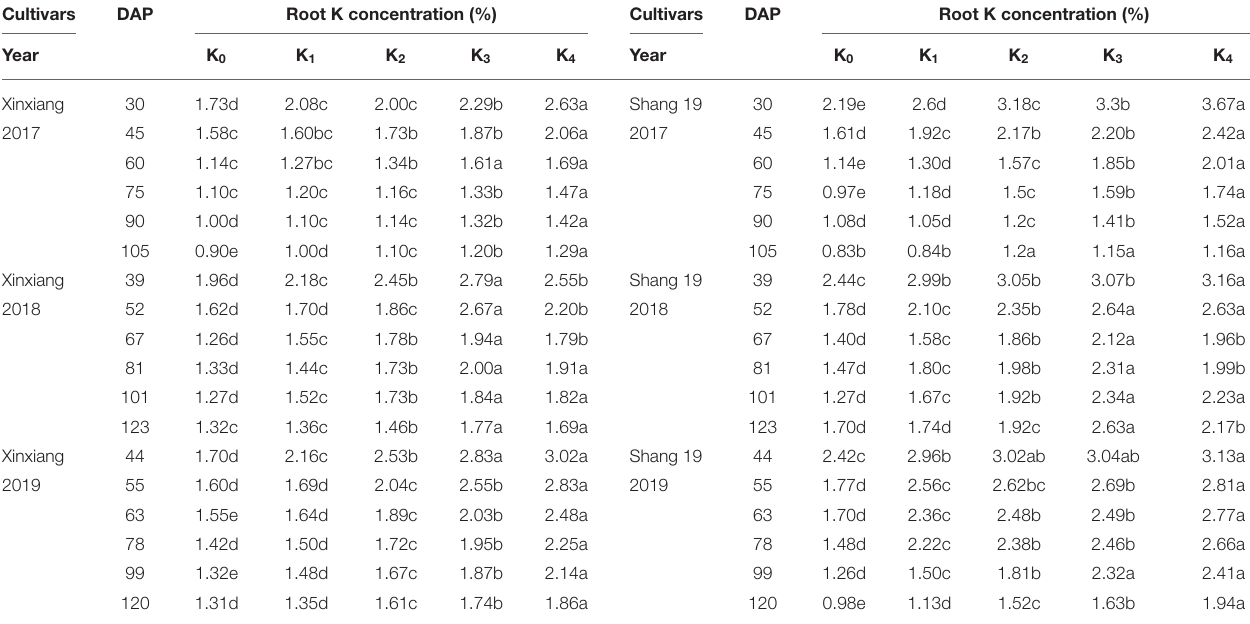
TABLE 4 | Root K concentration for sweet potato grown under different K application rates in three field experiments. Cultivars DAP Root K concentration (%) Cultivars DAP Root K concentration (%)